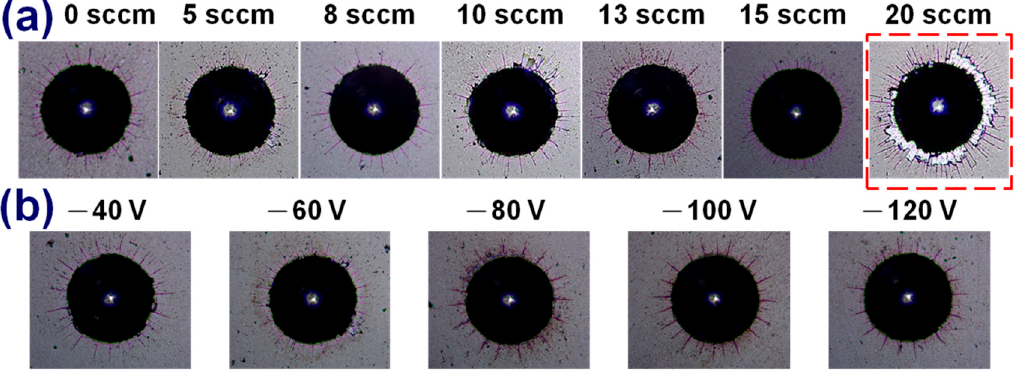
Figure 9. Rockwell indentation results of AlCrCN deposited as function of ( a ) C 2 H 2 flow rate and ( b ) bias voltage.